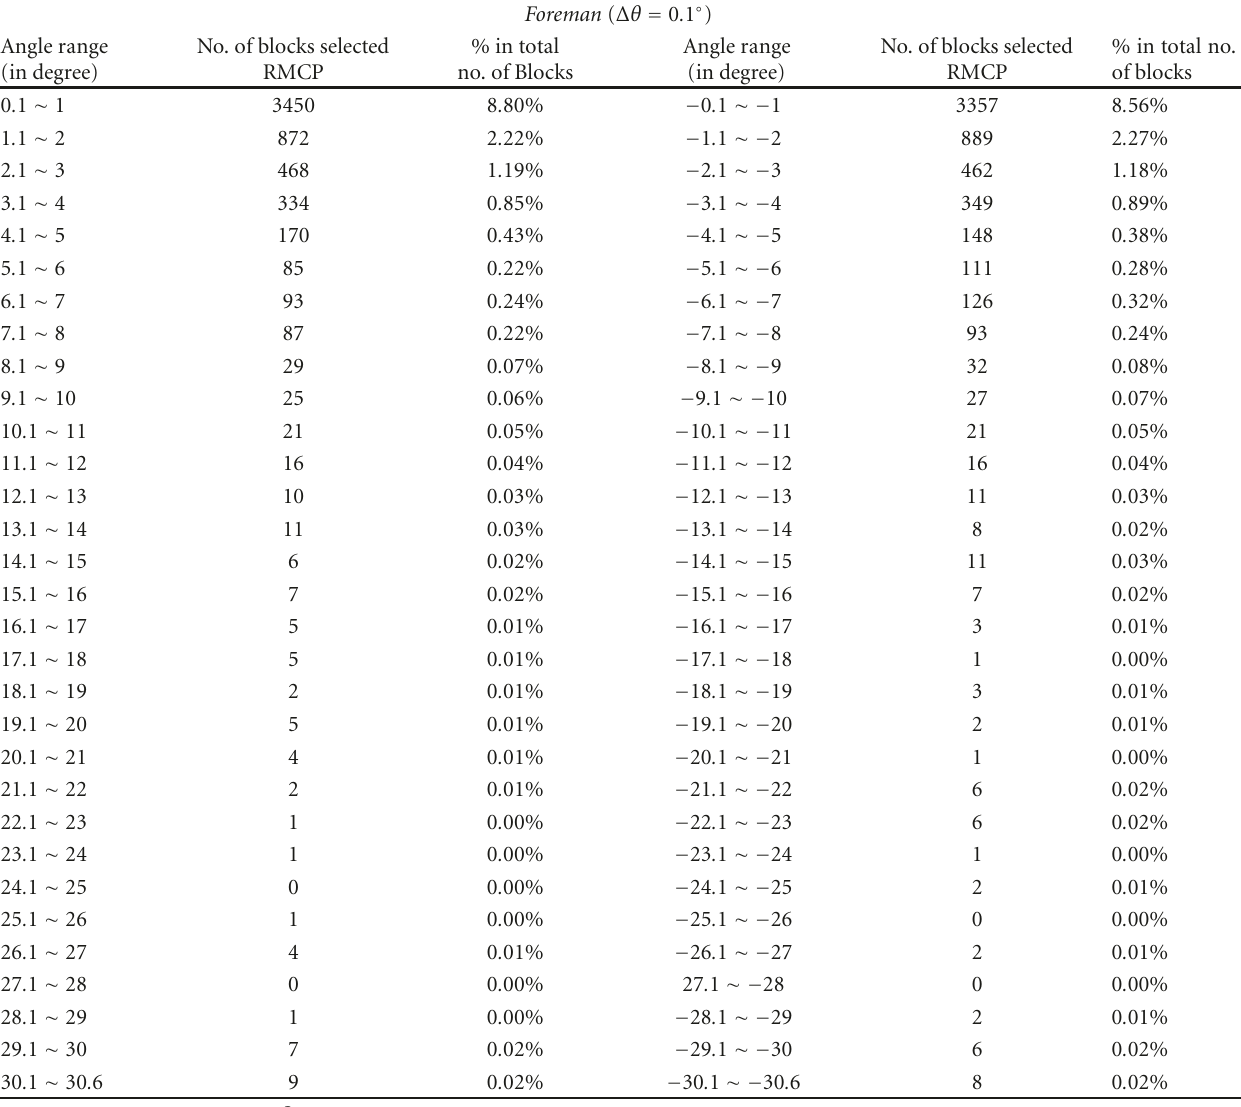
Table 1: Rotation angle distribution in sequence